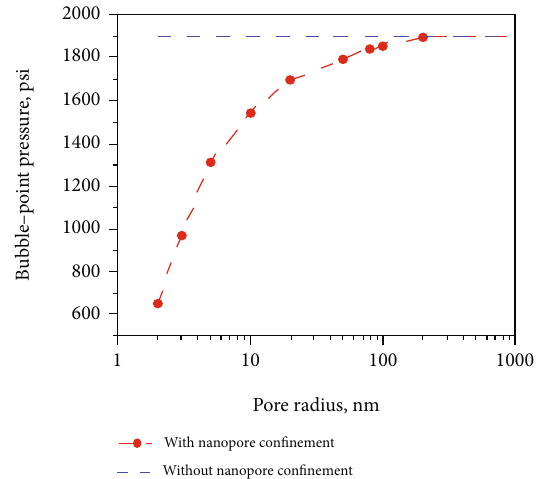
Figure 5: Bubble point pressure of the Bakken tight oil at various pore radii at T = 230 ° F.